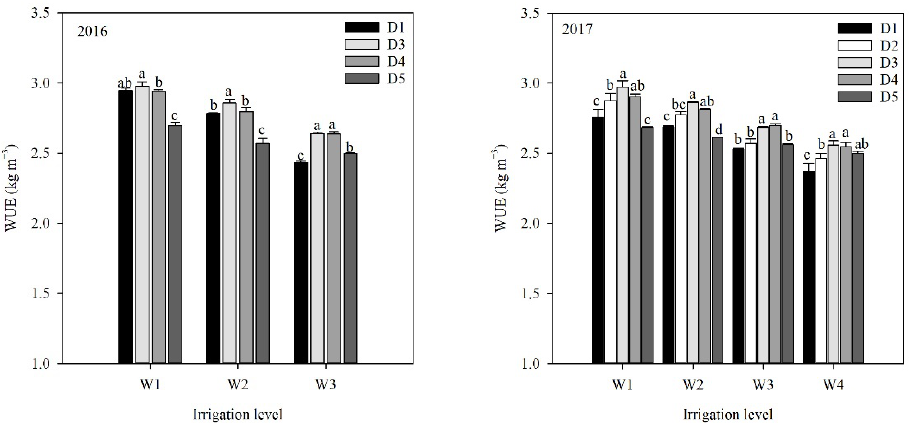
Figure 3. Changes of water use efficiency under different irrigation levels and planting densities during the 2016 and 2017 maize growing seasons. WUE, water use efficiency. W1, W2, W3, and W4 represent irrigation levels of 360, 480, 600, and 720 mm, respectively. D1, D2, D3, D4, and D5 represent planting densities of 7.5, 9.0, 10.5, 12.0, and 13.5 plants m − 2 , respectively. Means within a column and for the same site followed by different letters are significantly different at p < 0.05.